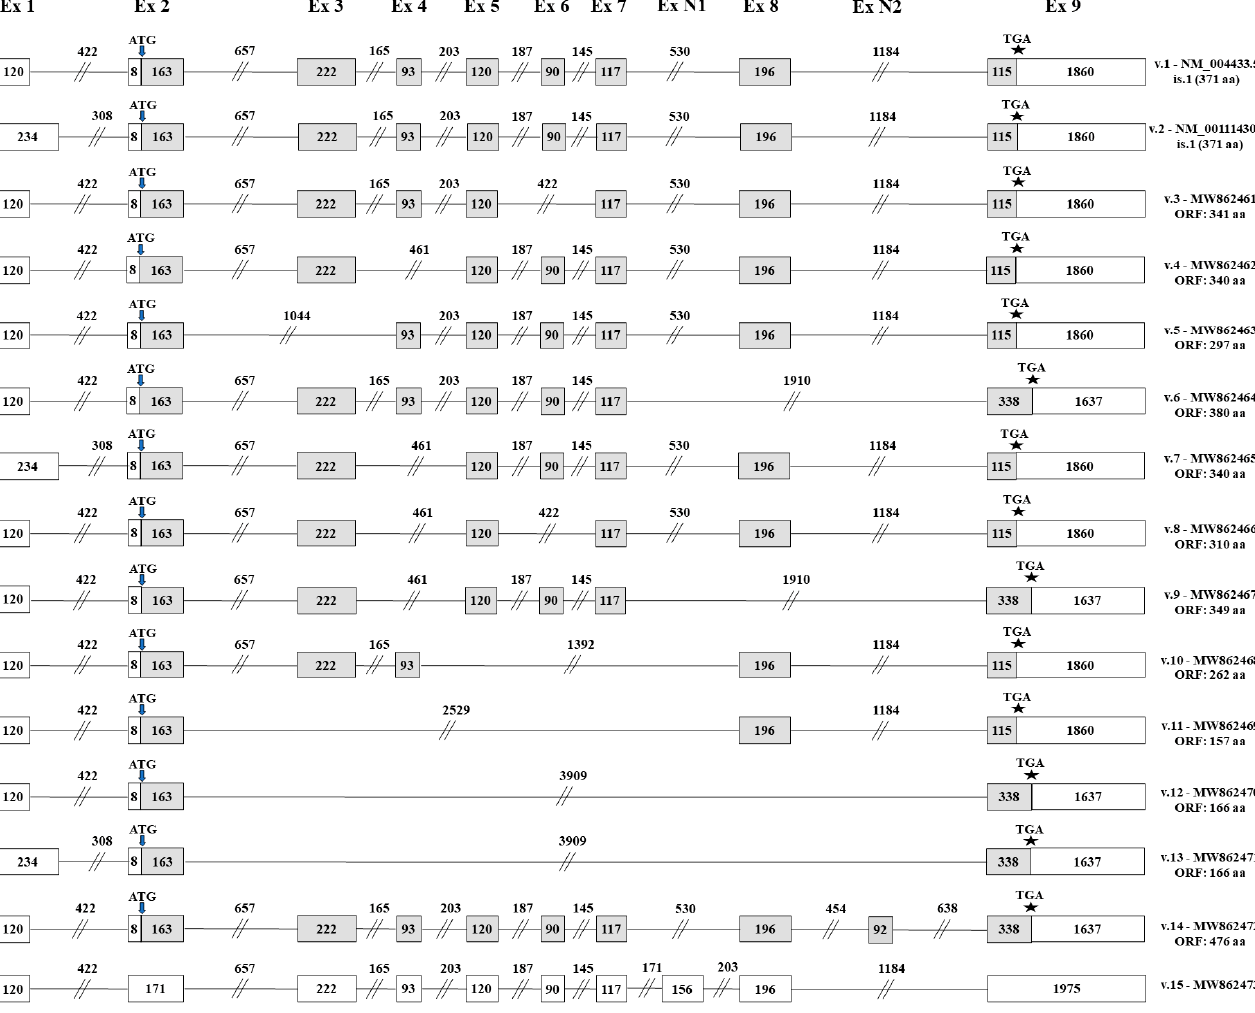
Figure 3. Detailed structure of the novel ELF3 transcript variants sharing the annotated initiation codon. Exons are shown as boxes and introns as lines, while the numbers that characterize every box and line indicate their length in nucleotides. Gray and white boxes represent coding and non-coding exons, respectively. The positions of the ATG and TGA codons are pointed out with arrows ( ↓ ) and asterisks (*), accordingly.